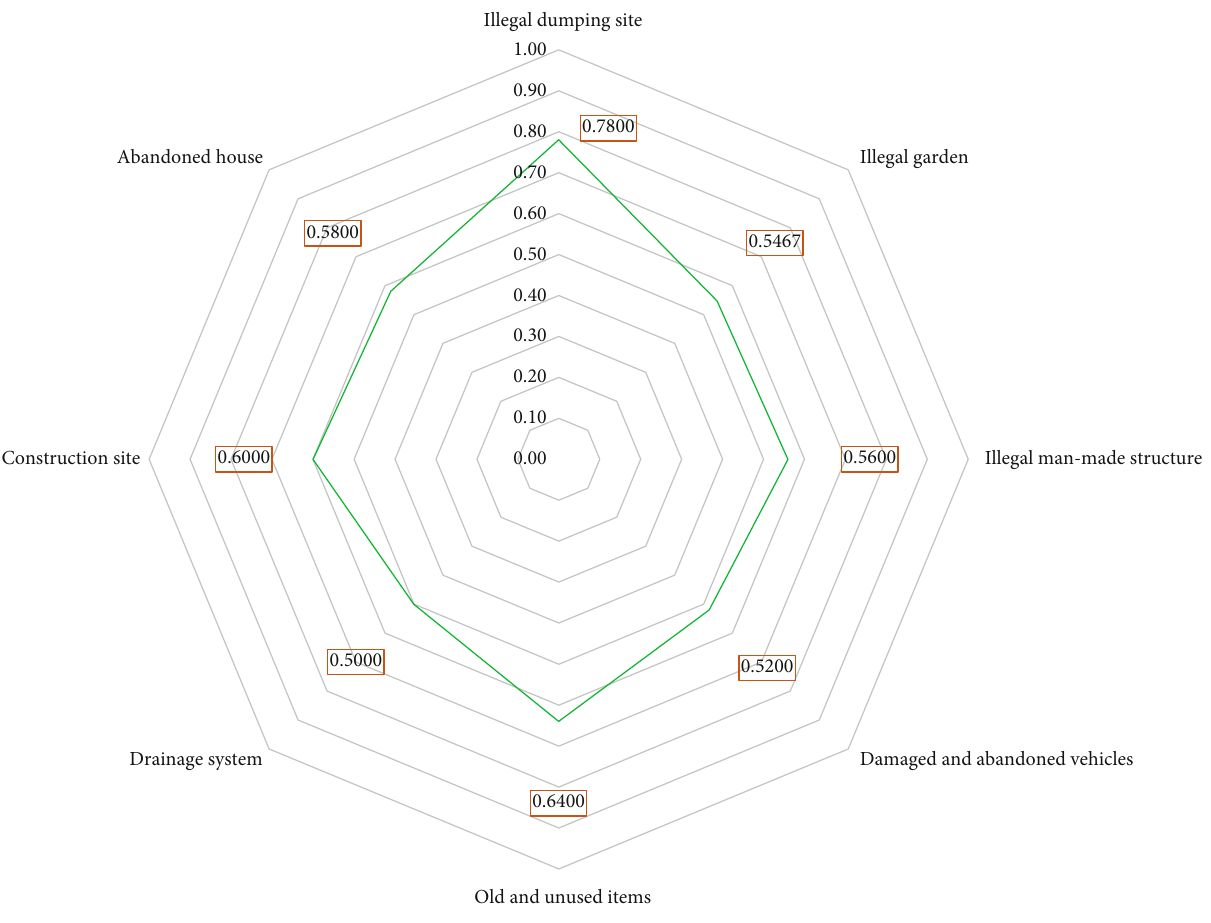
Figure 2: Spider diagram representing expert analysis of risk factors. Table 4: Fuzzy Delphi result (ranking of socioecological